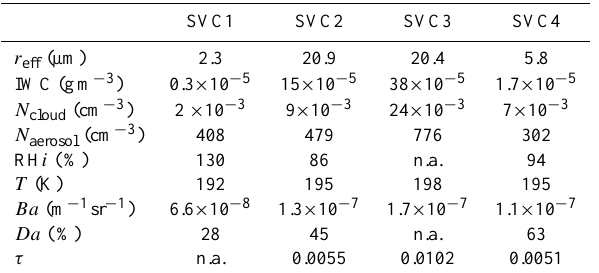
Table 4. Summary of the microphysical parameters of the four West African SVC cases in August 2006. The parameters include effec- tive radius ( r eff ), number concentrations for cloud particles ( N cloud , larger 2.7µm) and aerosol particles ( N aerosol , larger 15nm), aerosol volume backscatter coefficient ( Ba ), and aerosol depolarisation ra-